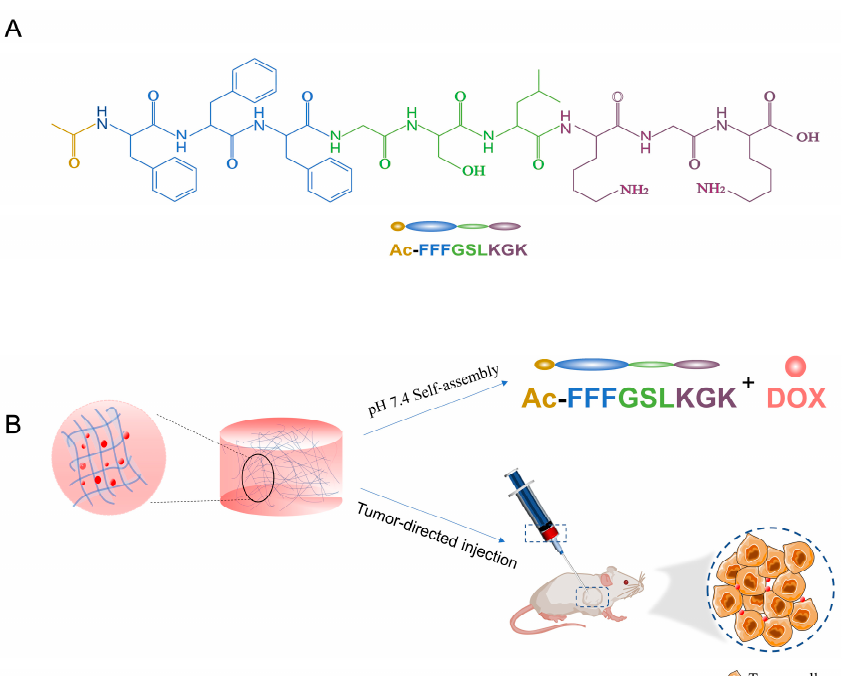
Figure 1. Schematic illustration of pH-responsive and injectable DOX-loaded hydrogels as drug delivery systems for carcinoma therapy. ( A ) Molecular structure of Ac-FFFGSLKGK. ( B ) The peptide can self-assemble into hydrogels in neutral conditions and effectively encapsulate DOX. After intratumoral injection, the DOX from DOX-loaded hydrogels was selectively released into the tumor regions.